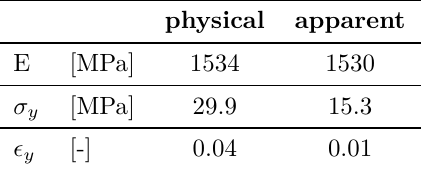
Table 1. Physical and apparent parent material prop- erties.